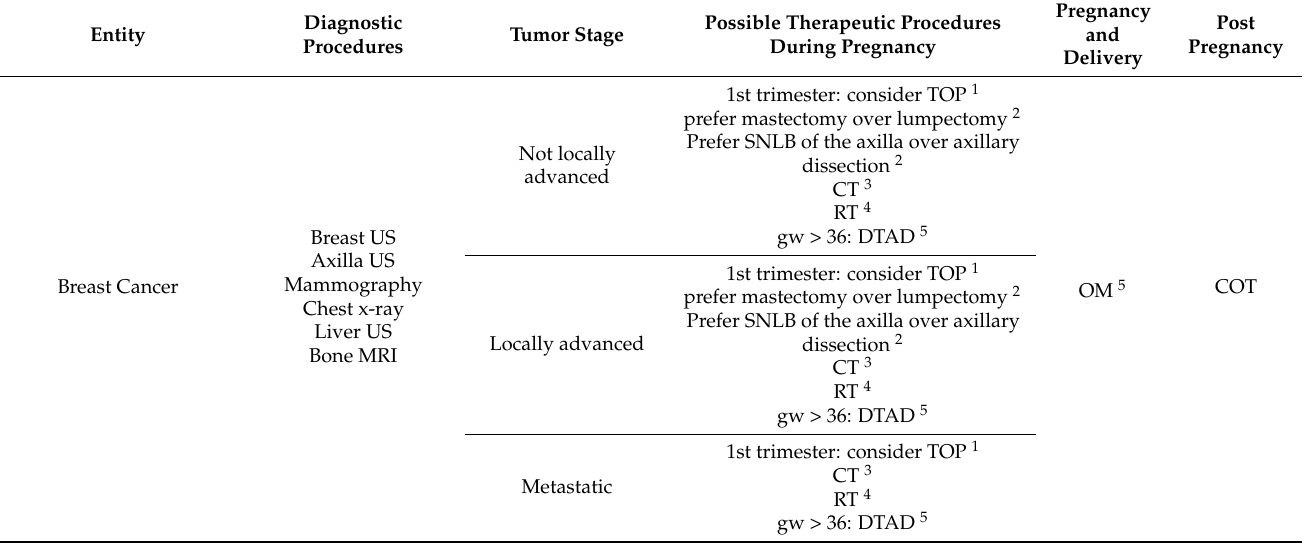
Table 1. Stage-adapted treatment of breast cancer and gynecological cancer diagnosed during